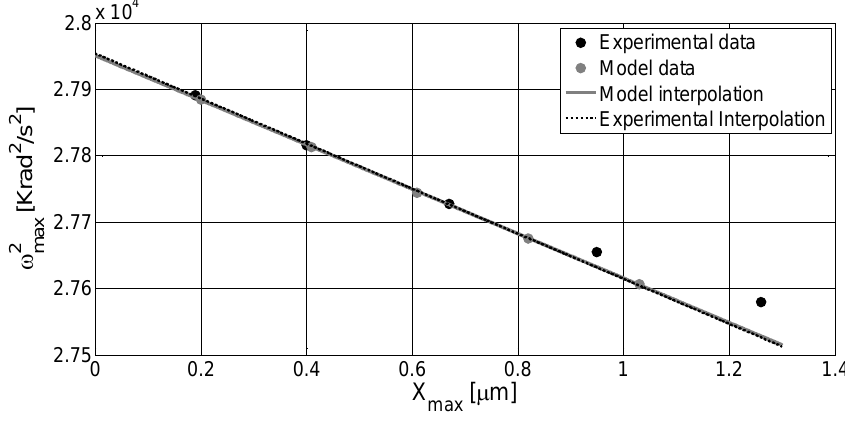
Figure 8. Evaluation of the theoretical model applying Equation (16). Dots are experimental and simulated data taken from Table 1. The continuous gray line is the interpolation of the numerical model, whereas the black dashed line is the linear approximation of the fist three elements in the experimental